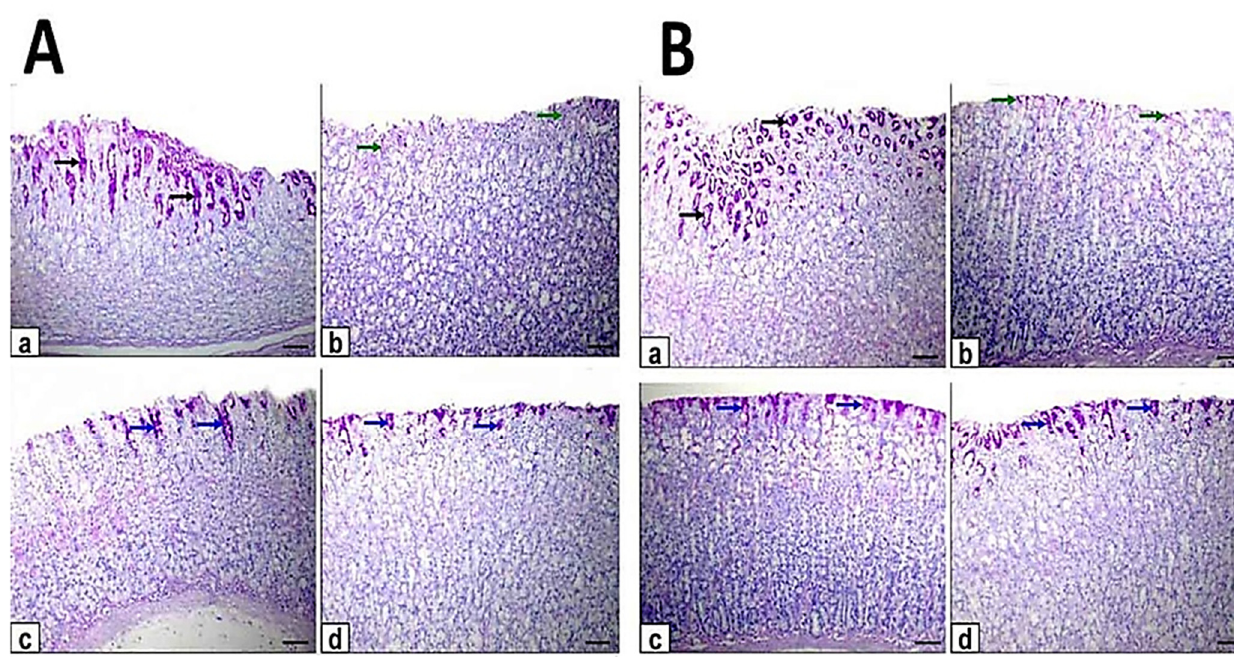
Figure 4. Photomicrographs of gastric sections stained with periodic acid Schiff (PAS). Scale bar = 100 µm. ( A ) The gastric sections of the pretreatment group: ( a ) control rats, ( b ) ethanol-induced ulcer rats on one hour, ( c ) MO-pretreated (MO-EtOH) rats, ( d ) ME-pretreated (ME-EtOH) rats. Arrows in the panels showed strong (black arrows), moderate (blue arrows), and faint (green arrows) PAS-positive reactions covering the surface epithelium. ( B ) The gastric sections of the treatment group: ( a ) control rats, ( b ) ethanol-induced ulcer rats on day 7, ( c ) MO-treated (EtOH-MO) rats, ( d ) ME-treated (EtOH-ME) rats. Arrows in the panels showed strong (black arrows), moderate (blue arrows), and faint (green arrows) PAS-positive reactions covering the surface epithelium. Table 5. Effect of myrrh oil and myrrh extract on periodic acid Schiff (PAS) staining and proliferating cell nuclear antigen (PCNA), caspase-3, and tumor necrosis factor- α (TNF- α ) immunohistochemical staining.